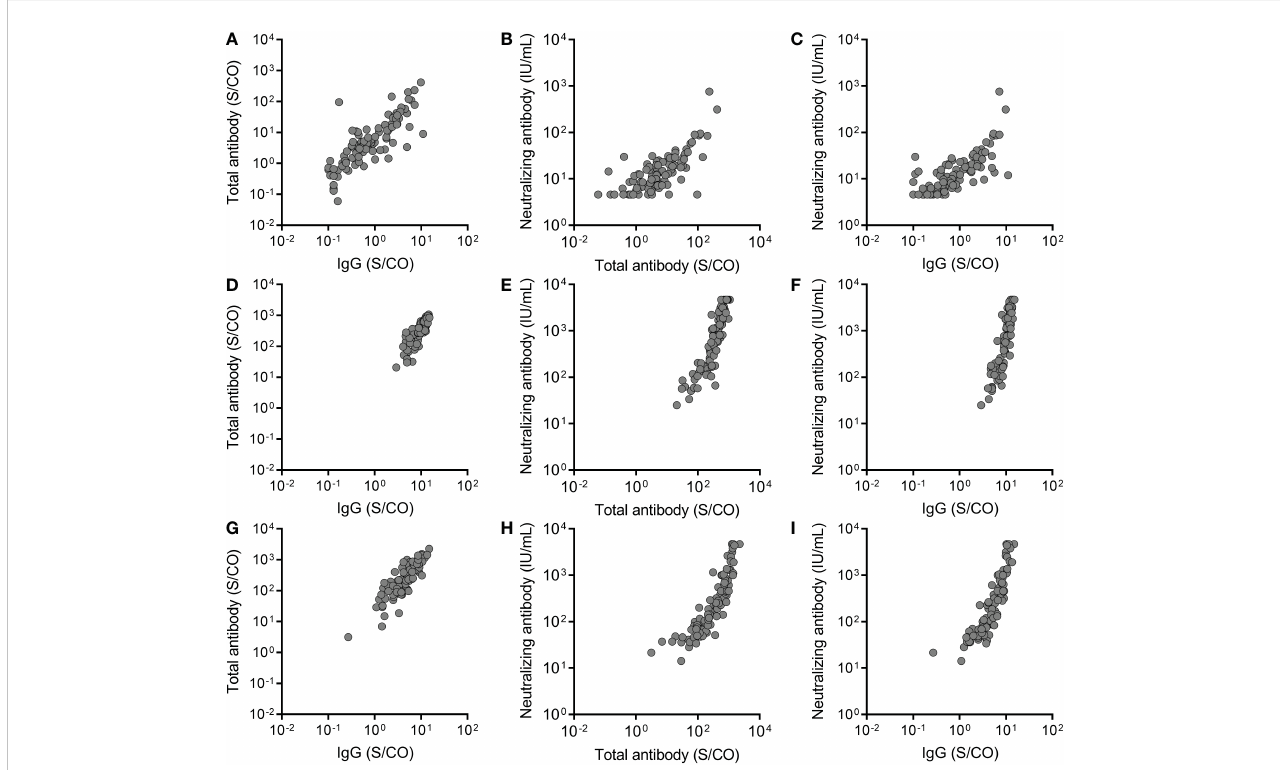
FIGURE 4 The relationship between total antibody and IgG antibody against the receptor binding domain (RBD) of the SARS-CoV-2 spike (S) protein and neutralizing antibody at three time points, before the third dose (A-C) , at month 1 after the third dose (D-F) and at month 6 after the third dose (G-I) . Spearman rank- correlation analysis was used to analyze the relationship between total antibody and IgG antibody against the RBD of the SARS-CoV-2 S protein and neutralizing antibody against SARS-CoV-2. A signi fi cant correlation was observed between total antibody and IgG at three time points (Before the third dose: P <0.0001, r= 0.8130; Month 1 after the third dose: P <0.0001, r= 0.8613; Month 6 after the third dose: P <0.0001, r= 0.8720). Signi fi cant correlations were observed between total antibody and IgG and neutralizing antibody before the third dose (for total antibody: P <0.0001, r = 0.7077; for IgG: P < 0.0001, r = 0.7657), at month 1 after the third dose (for total antibody: P <0.0001, r = 0.9243; for IgG: P < 0.0001, r = 0.8919), and at month 6 after the third dose (for total antibody: P <0.0001, r = 0.9339; for IgG: P < 0.0001, r =